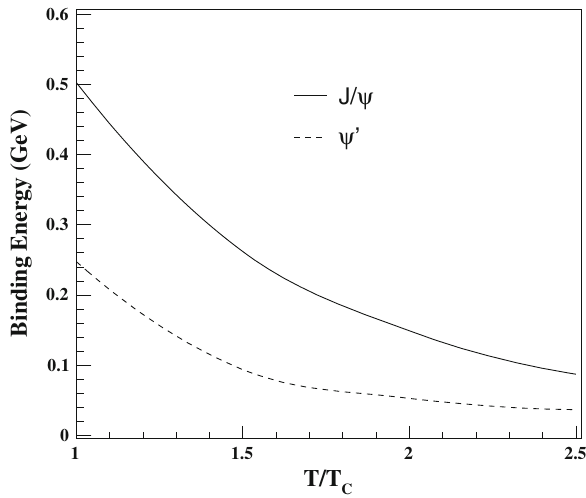
Fig. 10 Variation of binding energy (B.E.) with respect to temperature in units of T C . Solid and dashed curves represent the binding energy of J /ψ and ψ (cid:8) , respectively